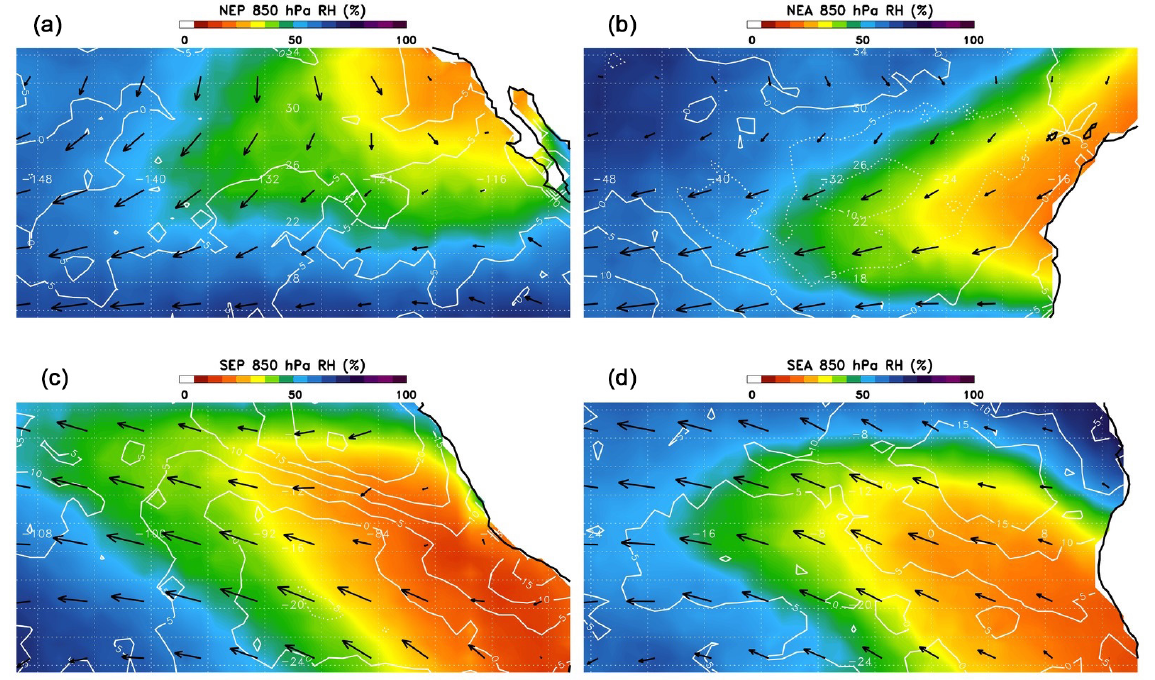
Figure 6. AIRS RH 850 (%) for regions listed in Table 1: (a) NEP, (b) NEA, (c) , SEP, and (d) SEA. The MERRA–AIRS RH 850 difference is shown as white contours (solid implies MERRA is moister, and dashed implies AIRS is moister). The length and direction of the arrows depict the 850hPa wind vectors from